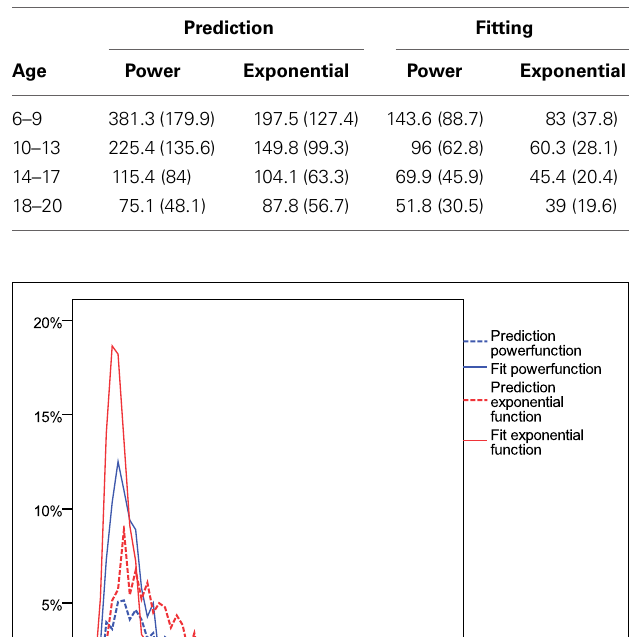
Table 3 | Average and standard deviation of RMSE per age group.